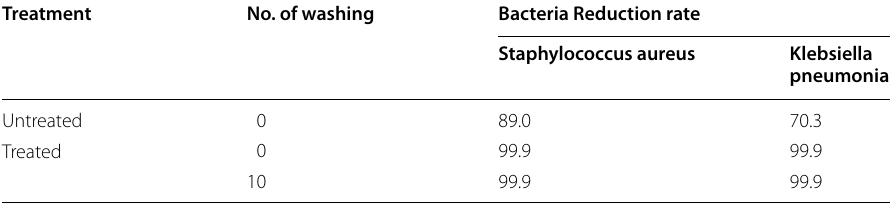
Table 4 Antibacterial activity of fabrics according to microcapsule treatment Treatment No. of washing Bacteria Reduction rate Staphylococcus aureus Klebsiella pneumoniae Untreated 0 89.0 70.3 Treated 0